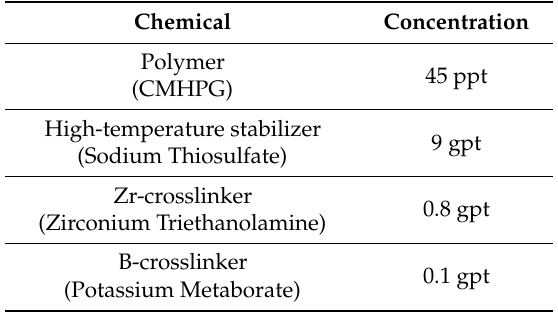
Table 1. Fracturing fluid formula.